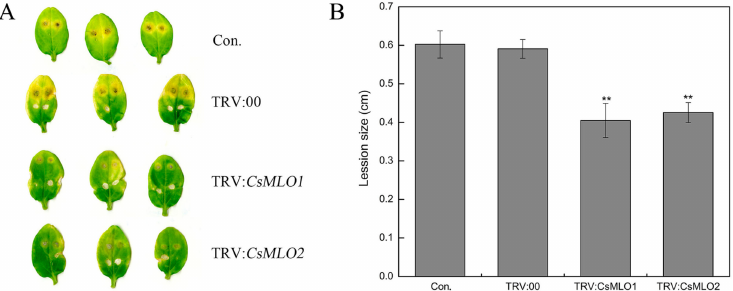
Figure 4. Identification of disease-resistance of silenced plants after C. cassiicola inoculation. ( A ) The lesion areas were observed in CsMLO1 -silenced and CsMLO2 -silenced cucumber cotyledons after C. cassiicola inoculation; ( B ) Lesion size was measured in CsMLO1 -silenced and CsMLO2 -silenced cucumber cotyledons after C. cassiicola inoculation. Data are means ± standard deviations from three biological replicates per cultivar. The asterisks indicated a significant di ff erence (Student’s t -test, *P < 0.05 or ** P <